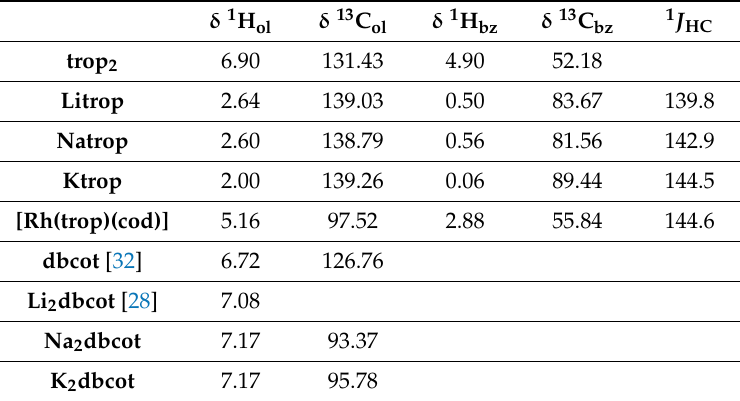
Table 1. Characteristic properties of the trop anions, the dbcot dianions and the reference compounds trop 2 and dbcot . Abbreviations: δ 1 H and δ 13 C: 1 H and 13 C NMR chemical shifts (ppm)